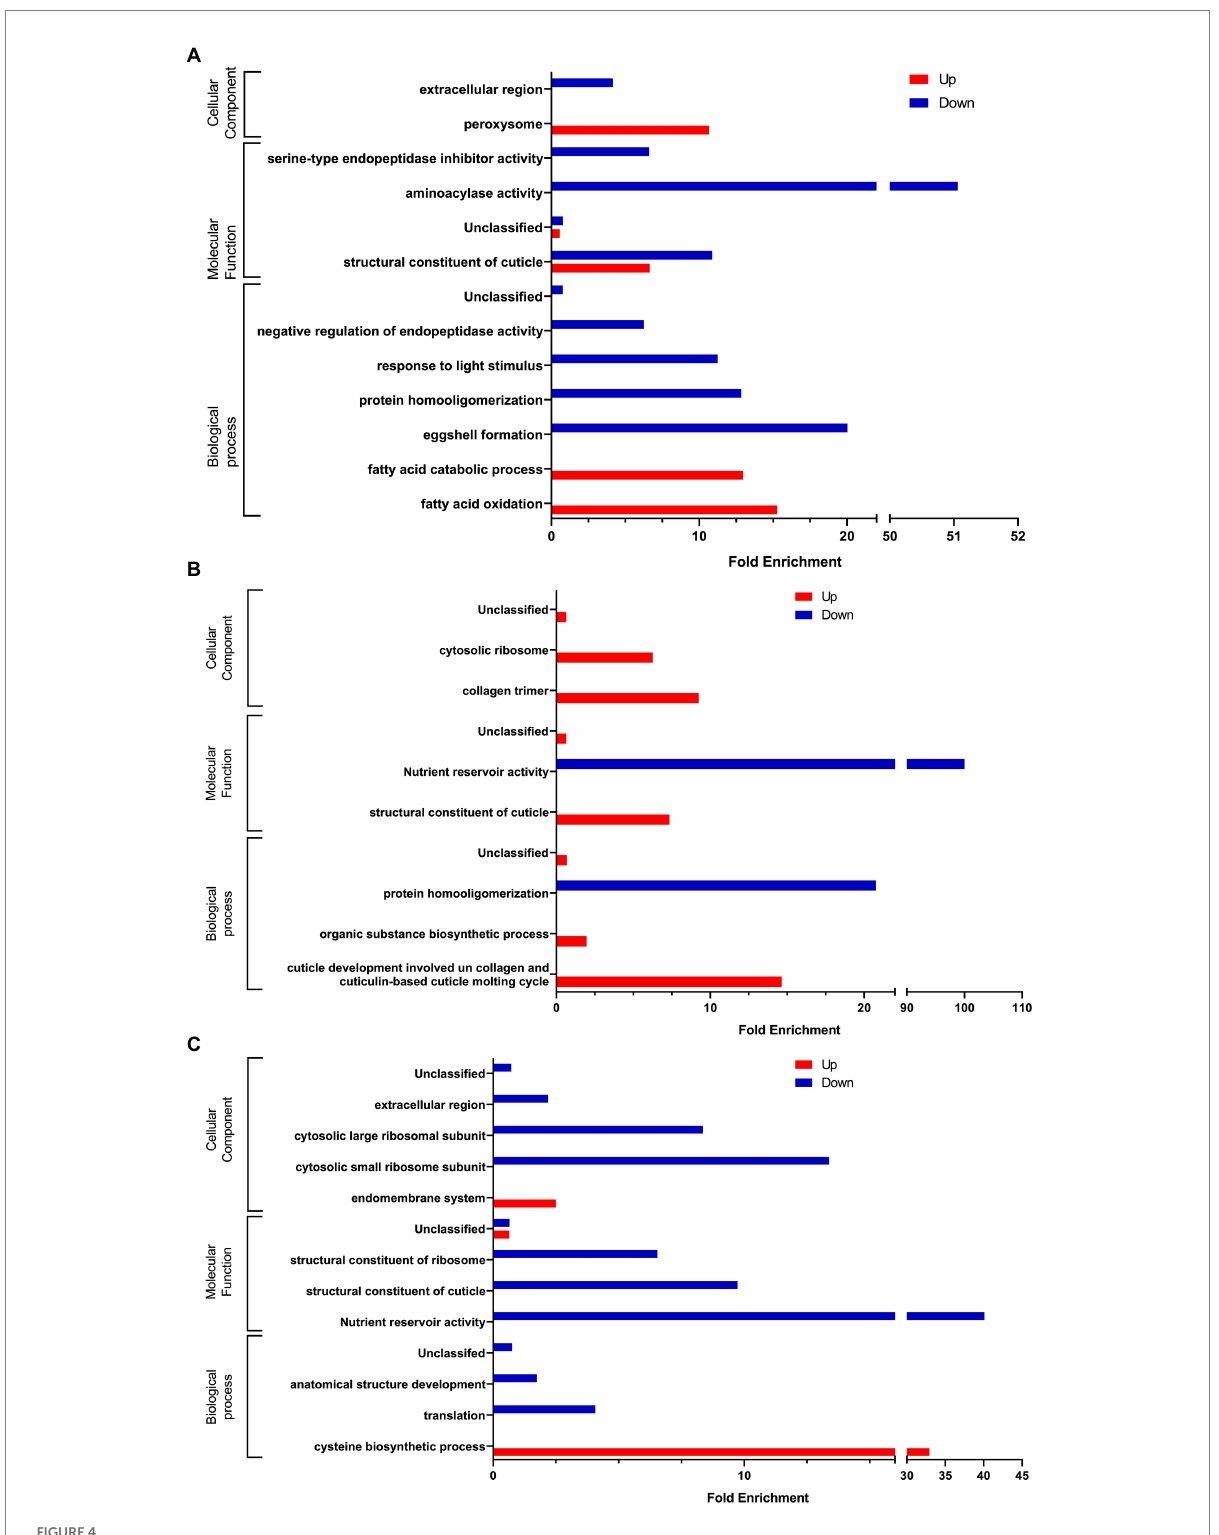
FIGURE 4 Gene Ontology analysis of differentially expressed genes (A) in presence of C. albicans versus E. coli OP50, (B) in presence of L. rhamnosus Lcr35 ® versus E. coli OP50, and (C) in presence of C. albicans versus L. rhamnosus Lcr35 ® . Only GO terms significantly enriched (value of p and false discovery rate < 0.05) are